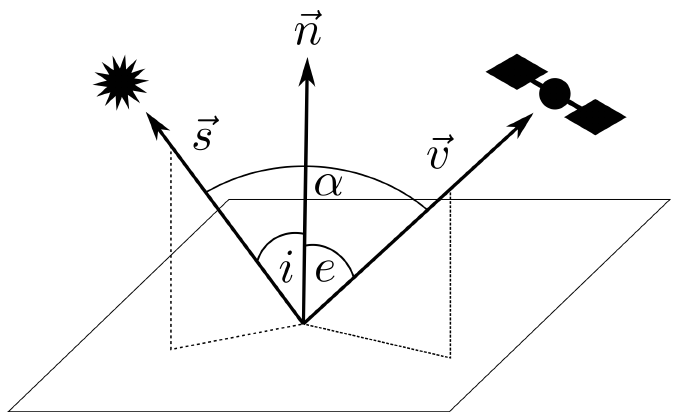
Figure A1. Illumination geometry. The normal of a surface element is (cid:126) n . The vector (cid:126) s points to the light source and spans the angle of incidence i with (cid:126) n . (cid:126) v points towards the observer with the emission angle e . The angle between (cid:126) s and (cid:126) v is the phase angle α